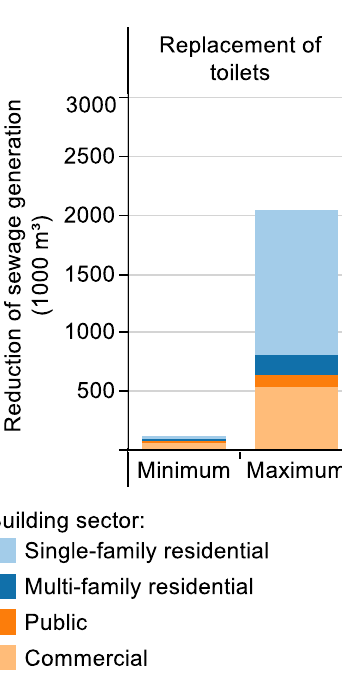
Figure 3. Minimum and maximum reductions of potable water consumption due to each strategy.